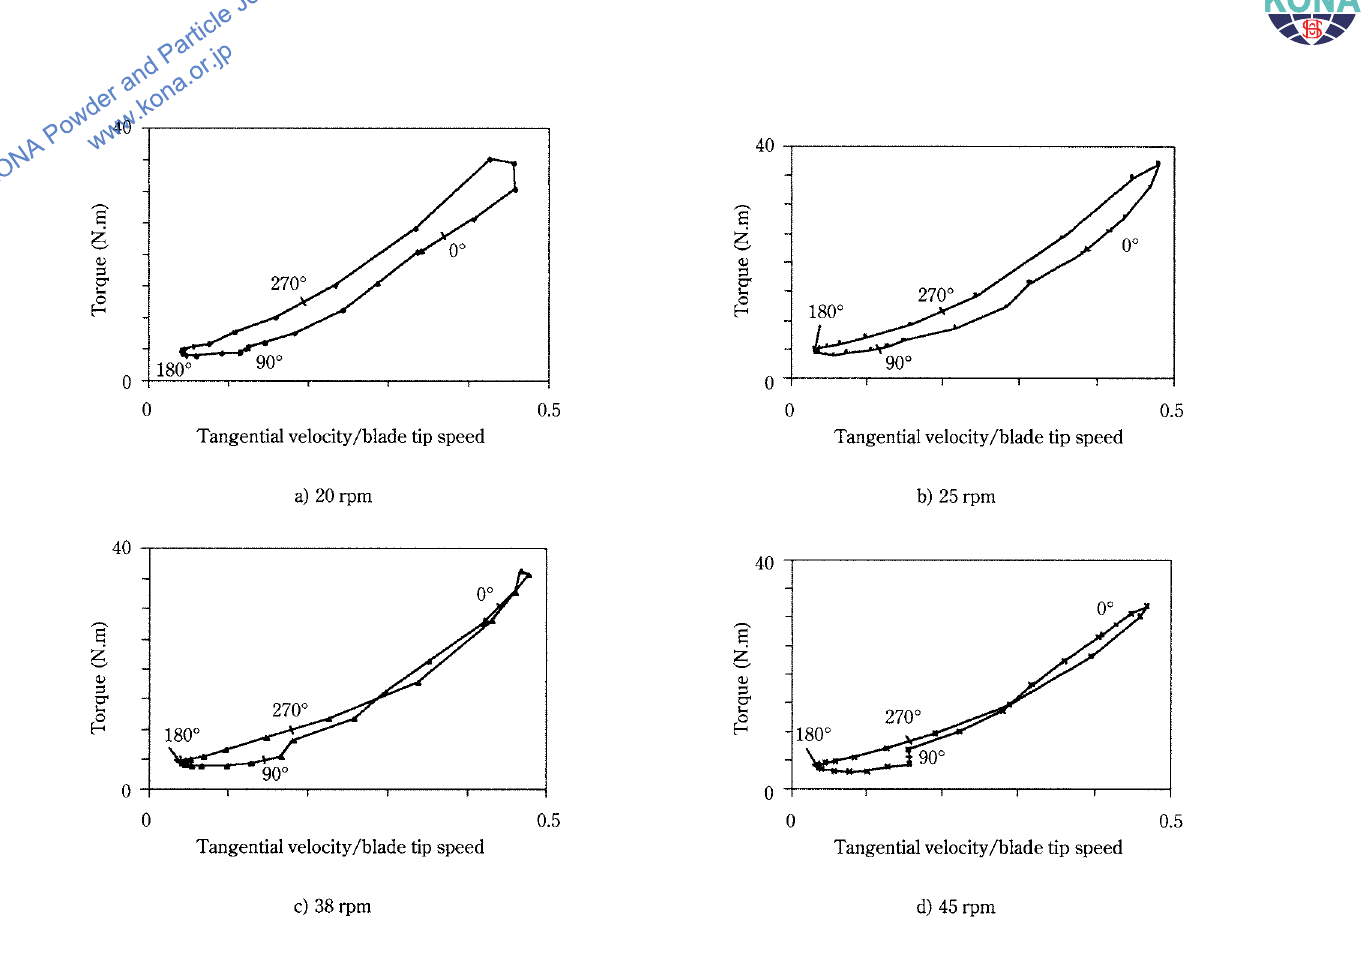
Influence of speed on the phase diagram (torque vs. tangential velocity), agitator B, 60% Parameters on curves: blade position in the bed; oo origin: blade in lower vertical position